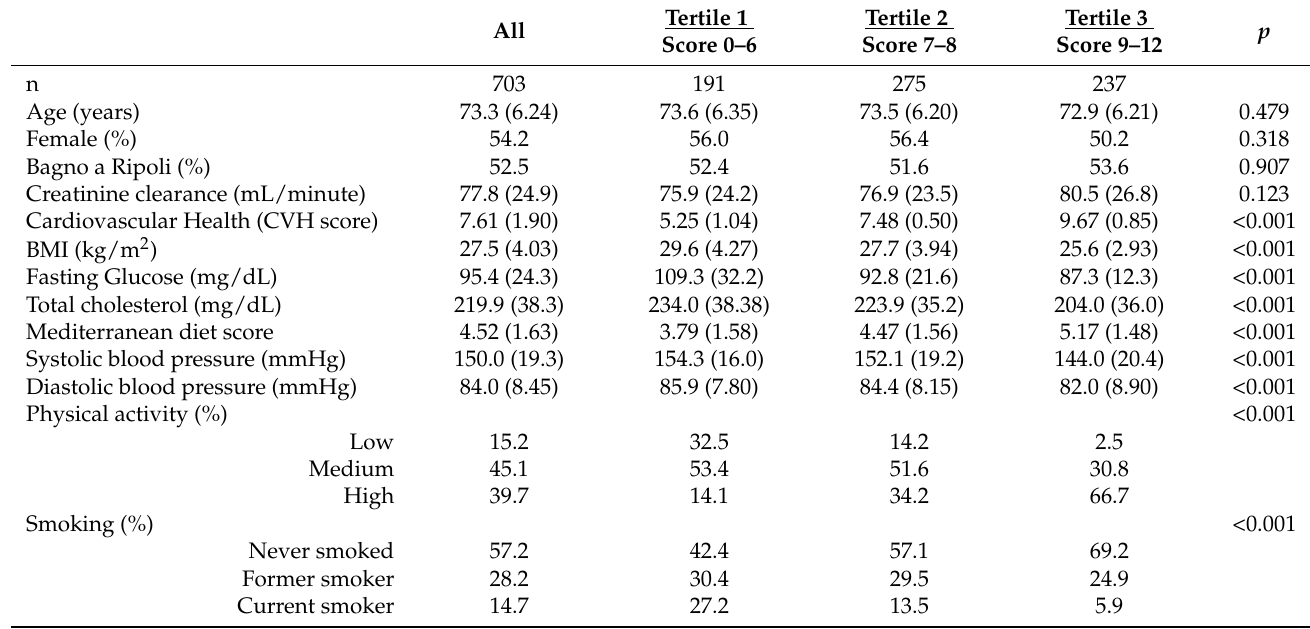
Table 1. Characteristics of InCHIANTI participants by tertile of CVH score.